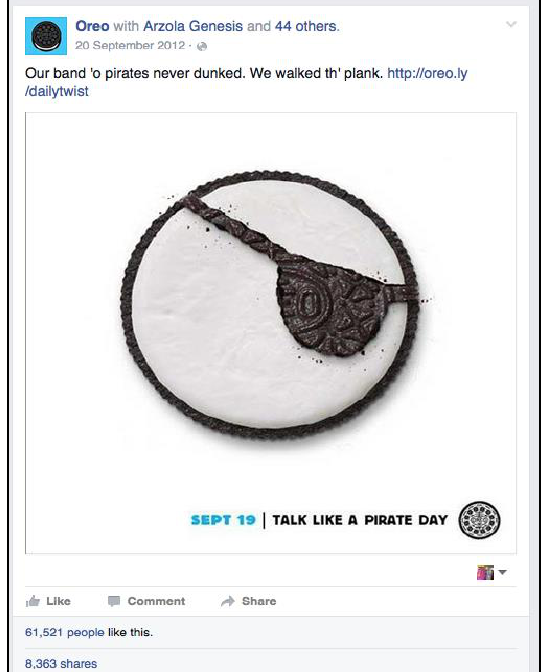
Figure 1. A typical post by the official Oreo cookie Facebook page. Source: https://www.facebook.com/oreo/timeline